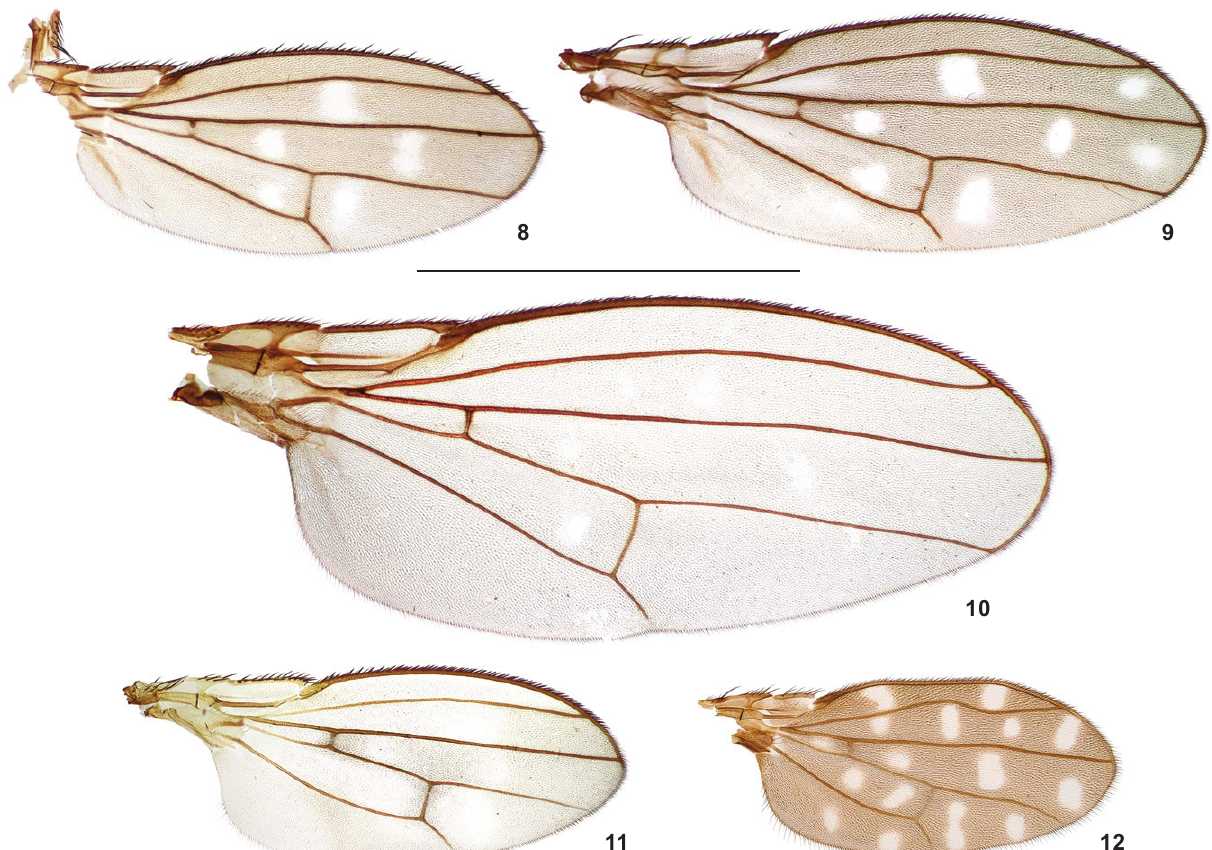
Figures 8-12. Wings, dorsal view: (8) Scatella praia sp. nov. , Brazil, Paraná: Antonina: (9) Scatella rara sp. nov. Brazil, Paraná: Curitiba, Parque Iguaçu; (10) Scatella plaumanni sp. nov. , Brazil, Santa Catarina: Nova Teutônia; (11) Scatophila prainha sp. nov. , Brazil, Paraná: Prainha (5 km S Matinhos); (12) Scatophila dianneae sp. nov. , Brazil, Paraná: Curitiba (Universidade Federal do Paraná, Reserva Biológica Mata Viva). Scale bar: 1.0